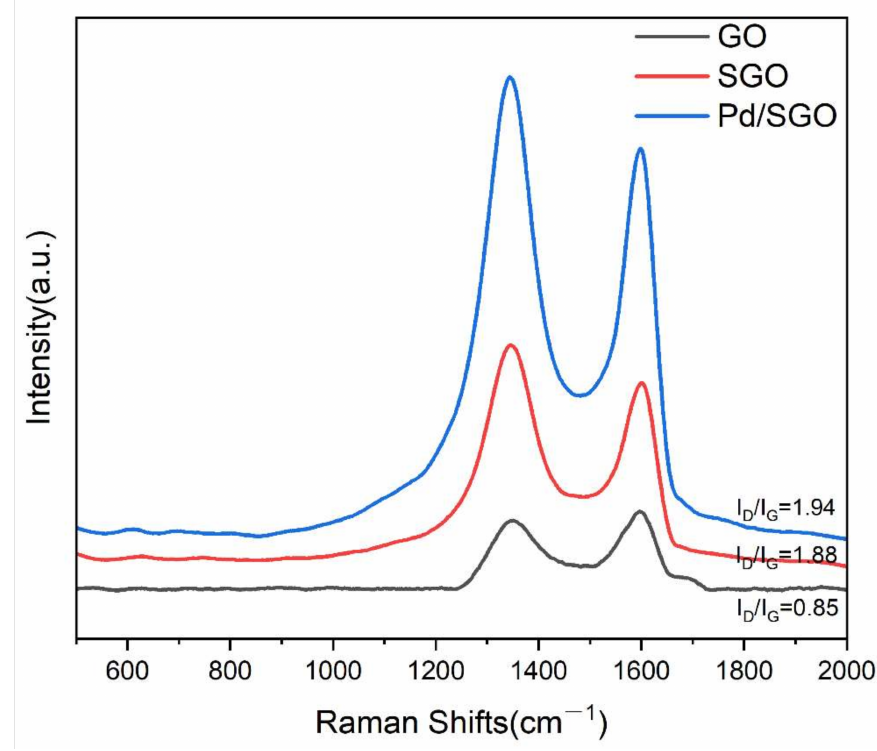
Figure 7. Raman spectra of GO, SGO, and